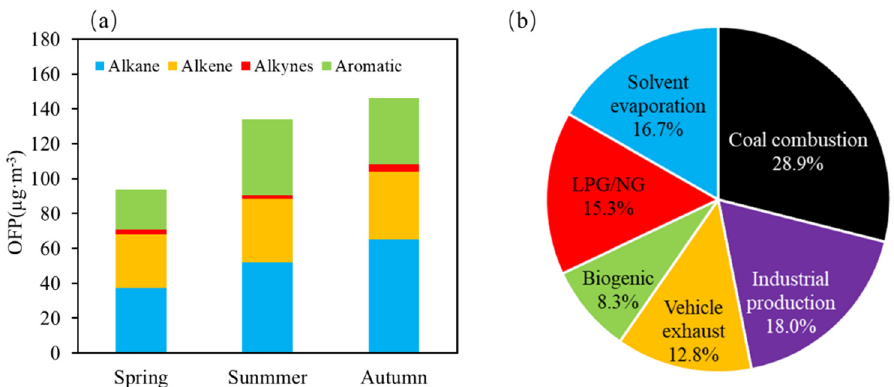
Figure 5. Contribution of ( a ) various VOCs groups and ( b ) various sources to OFP in Changzhi.